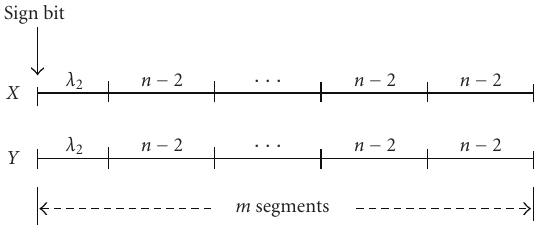
Figure 4: First level decomposition for a large size multiplication in Range 1.